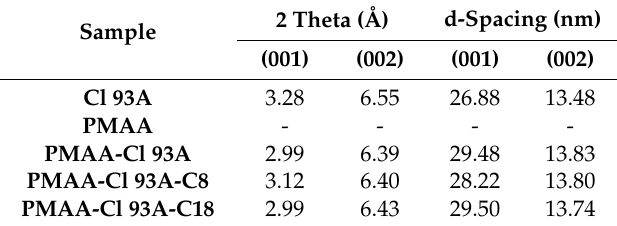
Table 1. XRD data obtained for the hydrogel nanocomposites.